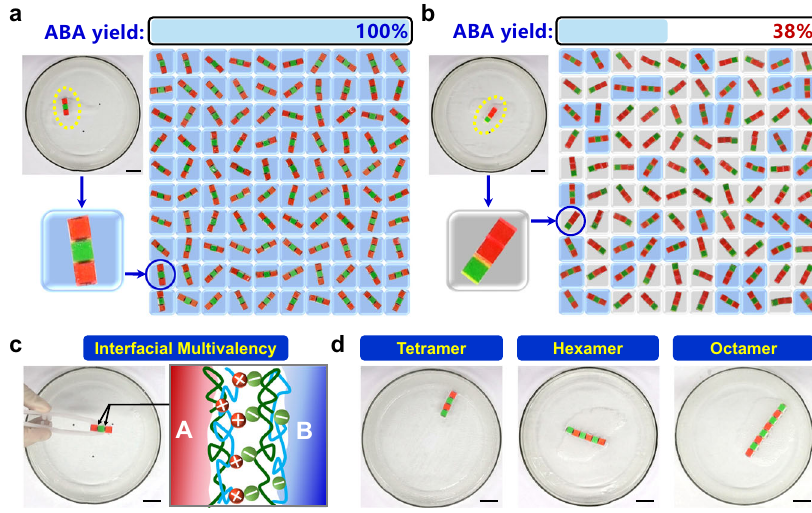
Fig. 4 | Application of the self-sorting mechanism for selective assembly of speci fi cstructures. AveragedMSAresultsof100parallelassemblyeventswithtwo As and one B, leading to different yields of the alternate ABA structures: a ABA yield=100%whencapillary/magneticforceswerecombined; b ABAyield=38%when onlycapillaryforceswerepresent. c TheassembledABAstructurewasimmediately